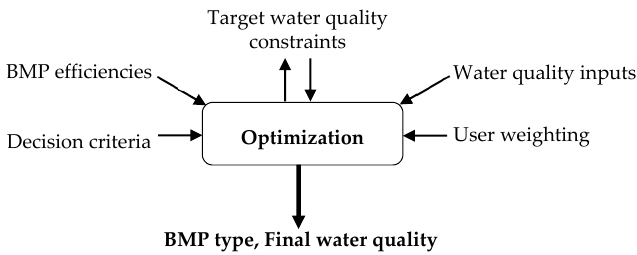
Figure 2. Conceptual framework of BMP selection module.